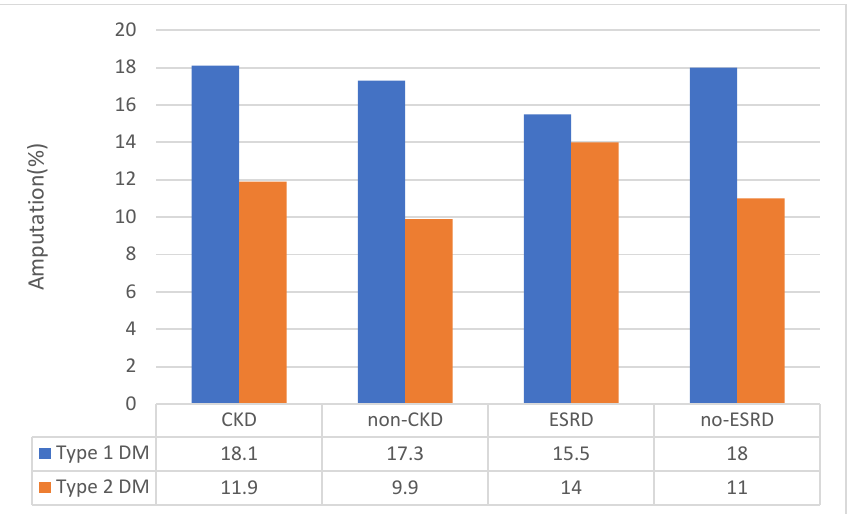
Figure 3. Proportion of type 1 and type 2 diabetes patients based upon presence and absence of CKD and ESRD that underwent amputation procedures. CKD, chronic kidney disease; DM, diabetes mellitus; ESRD, end-stage renal disease.